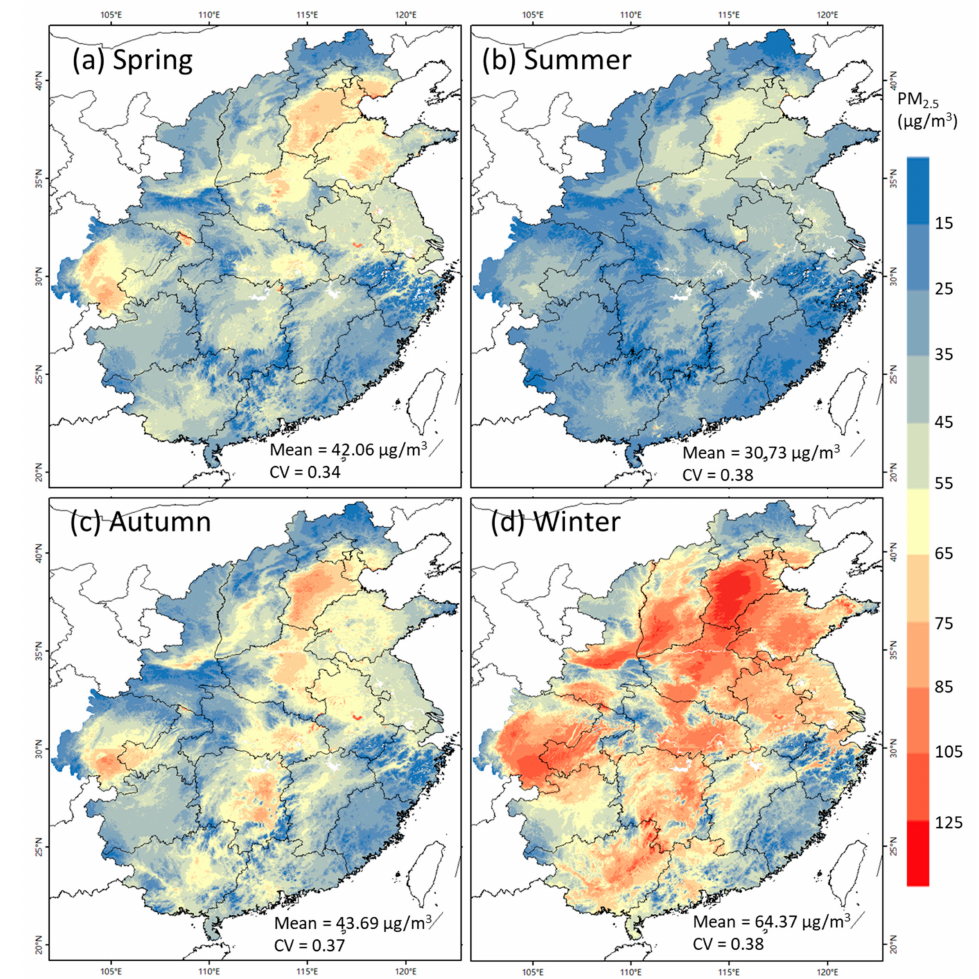
Figure A3. Spatial distributions of seasonal mean PM 2.5 from 2001 to 2018 (CV represents the coefficient of variation).